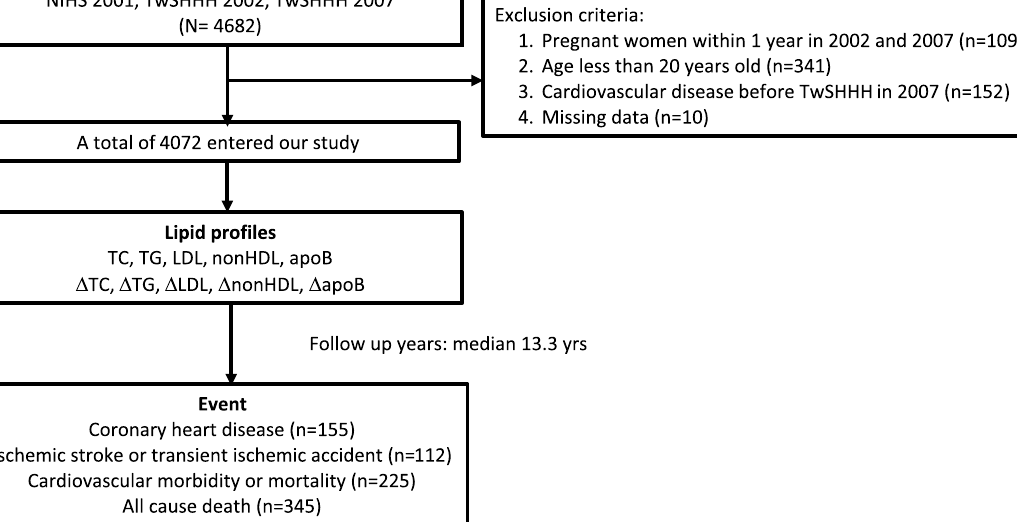
Figure 1. Flow chart of the study. NIHS National Health Interview Survey; TwSHHH Taiwanese Survey on Hypertension, Hyperglycemia, and Hyperlipidemia; TC total cholesterol; TG triglycerides; LDL-C low-density lipoprotein cholesterol; non-HDL-C non-high-density lipoprotein cholesterol; ApoB apolipoprotein